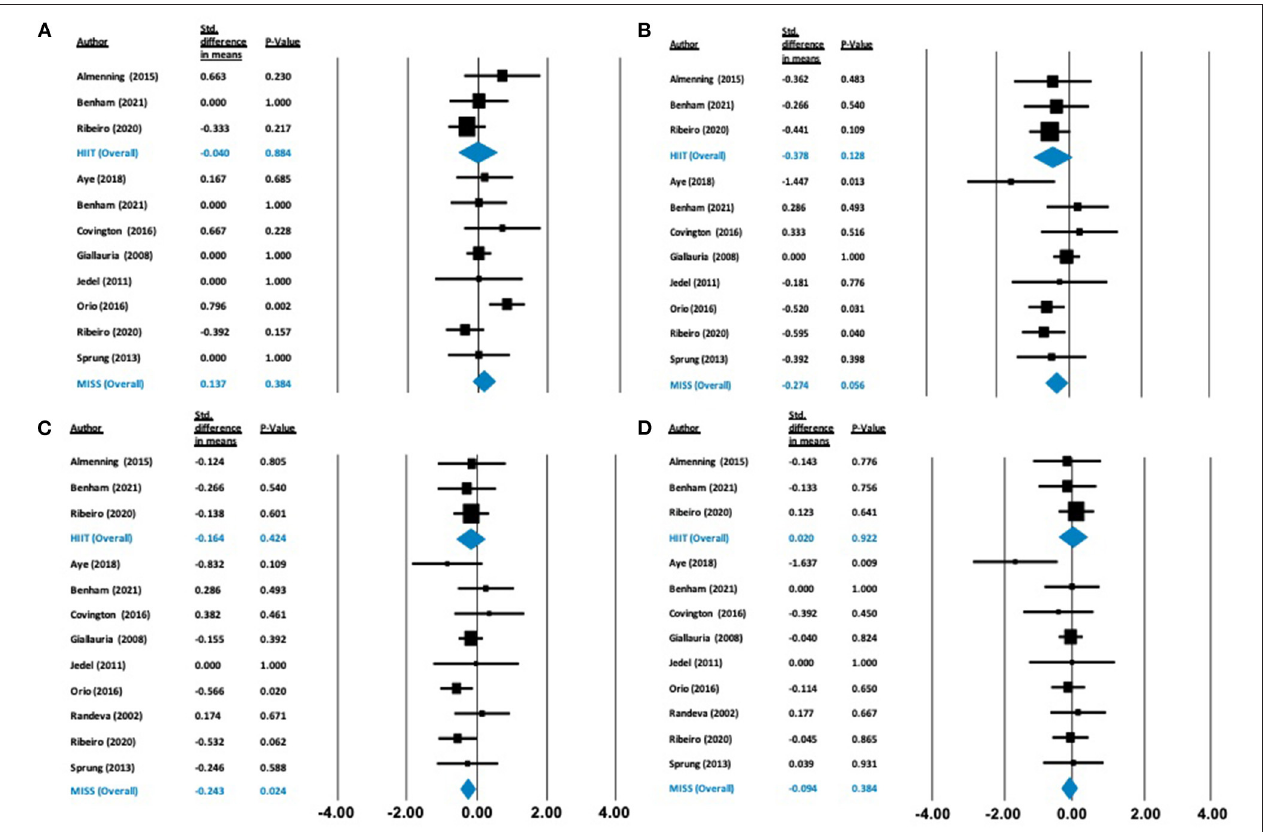
FIGURE 4 | Forest plots of standard difference in means 95% confidence intervals for: (A) HDL-C, (B) LDL-C, (C) T-C, and (D) triglycerides as measures of lipid ± profile. Filled squares represent study outputs. Lines represent 95% confidence intervals. Filled blue diamonds represent the weighted mean determined through meta-analyses.